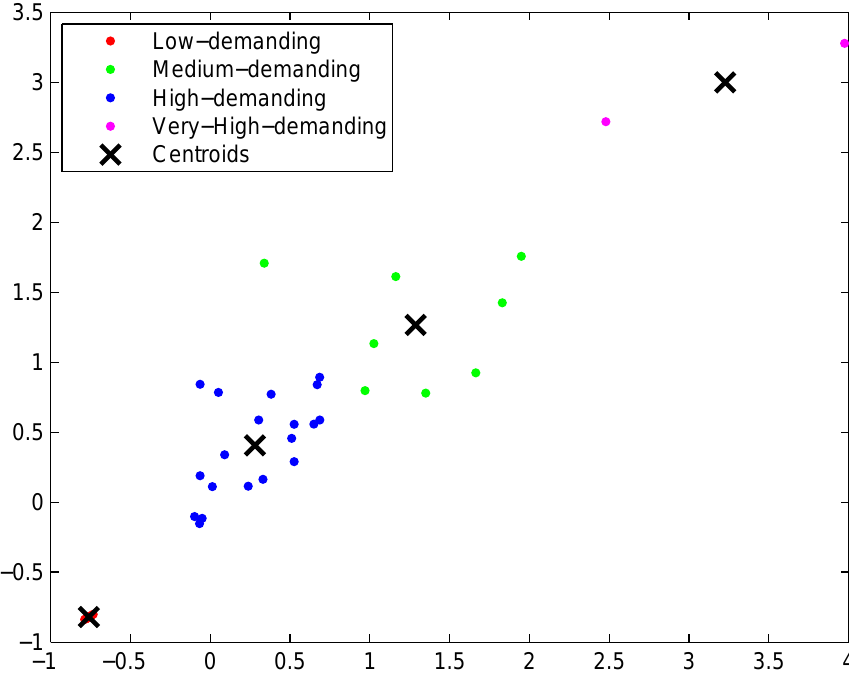
Figure 8. Clustering results. Projection over energy and time axis.